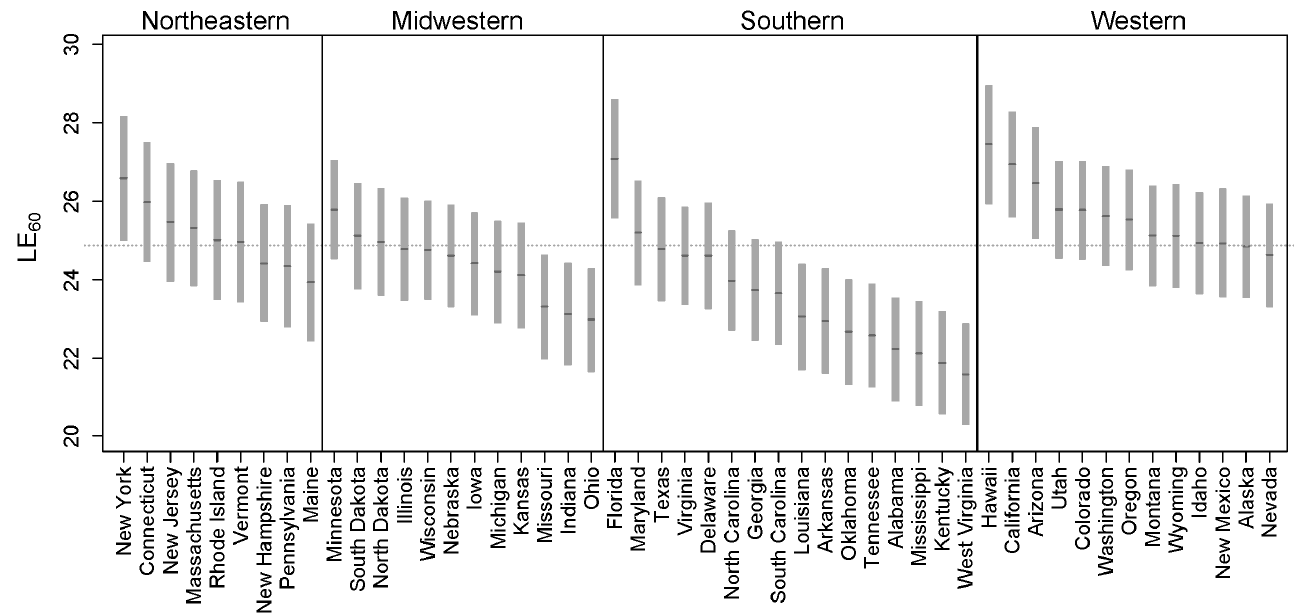
i US LE in 2030. Figure 11. The LE i , US in 60 60